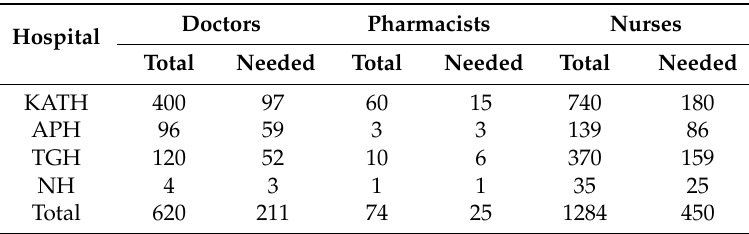
Table 1. Total cadres of each of the healthcare professionals against the desired sample sizes in the various